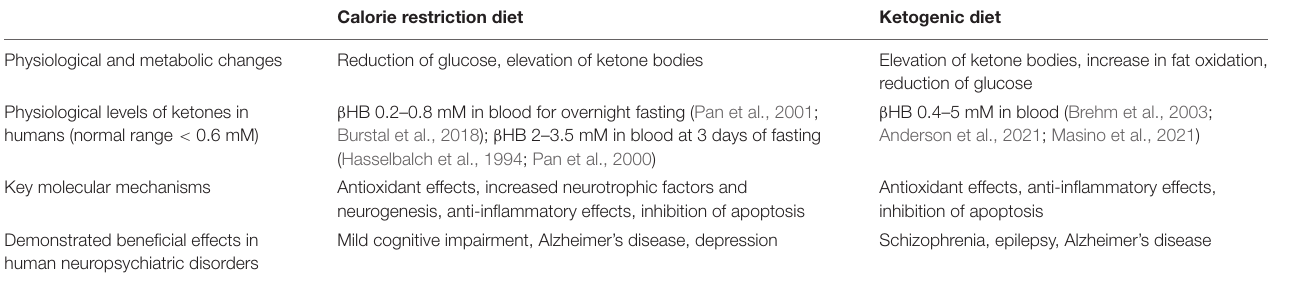
reduction of glucose